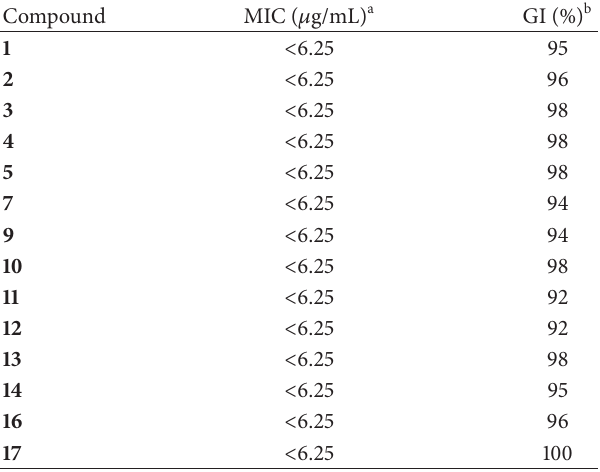
Table 1: Results of the primary antituberculosis screening of compounds 1–17 .